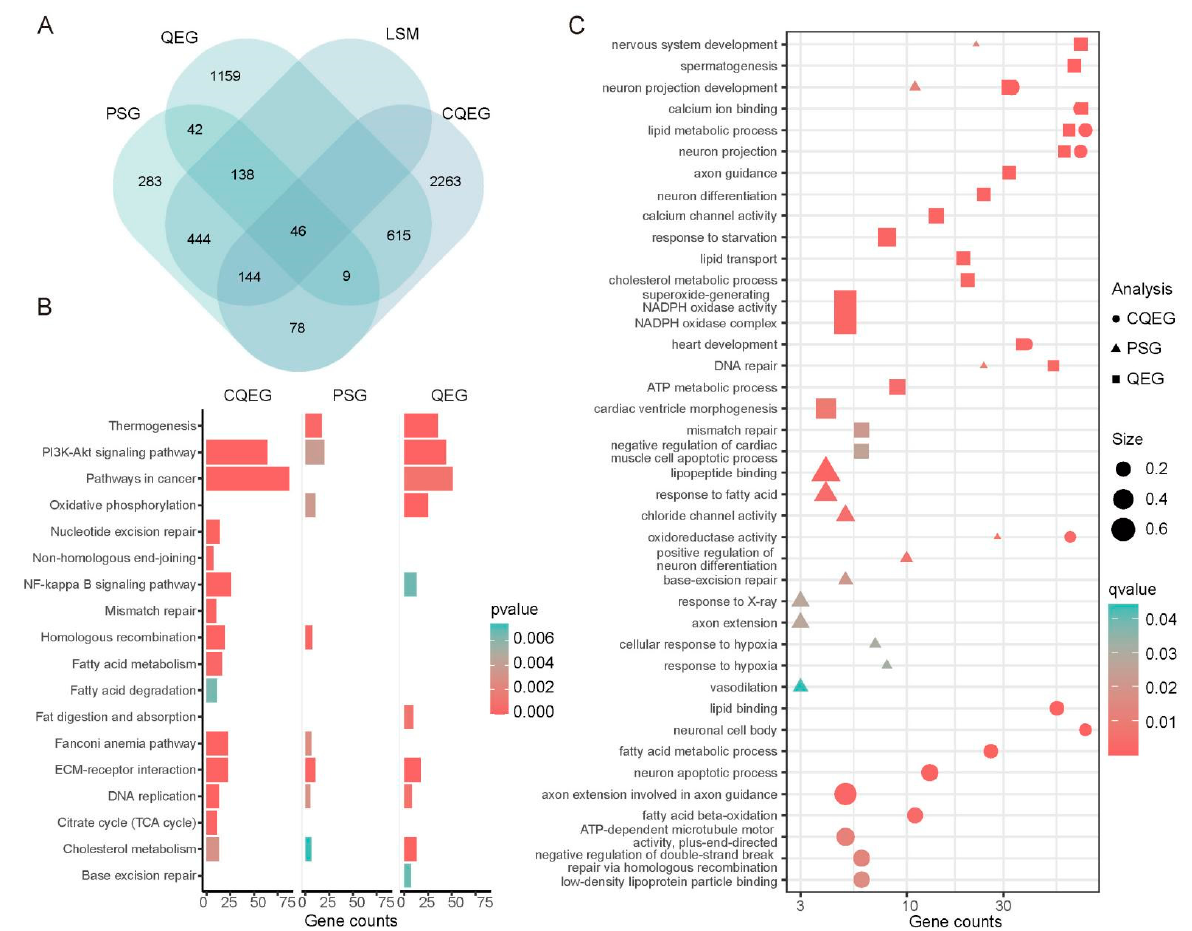
Figure 4. Comparative genomic analyses and functional enrichment of target genes. ( A ) Venn diagram showing numbers of target genes in different categories. PSGs and QEGs are positively selected genes and quickly evolving genes in L. sacra genome, respectively. CQEG represents common QEG. LSM represents genes with L. sacra -specific mutations. ( B ) Significantly enriched KEGG pathways in different gene categories. Color indicates enrichment p -value. Length of bar represents number of genes in a certain gene category. ( C ) Significantly enriched GO terms in different gene categories are represented by different shapes. Shape size represents number of genes in a certain category divided by the number of annotations for the corresponding GO term. Color indicates adjusted enrichment p -value (i.e.,